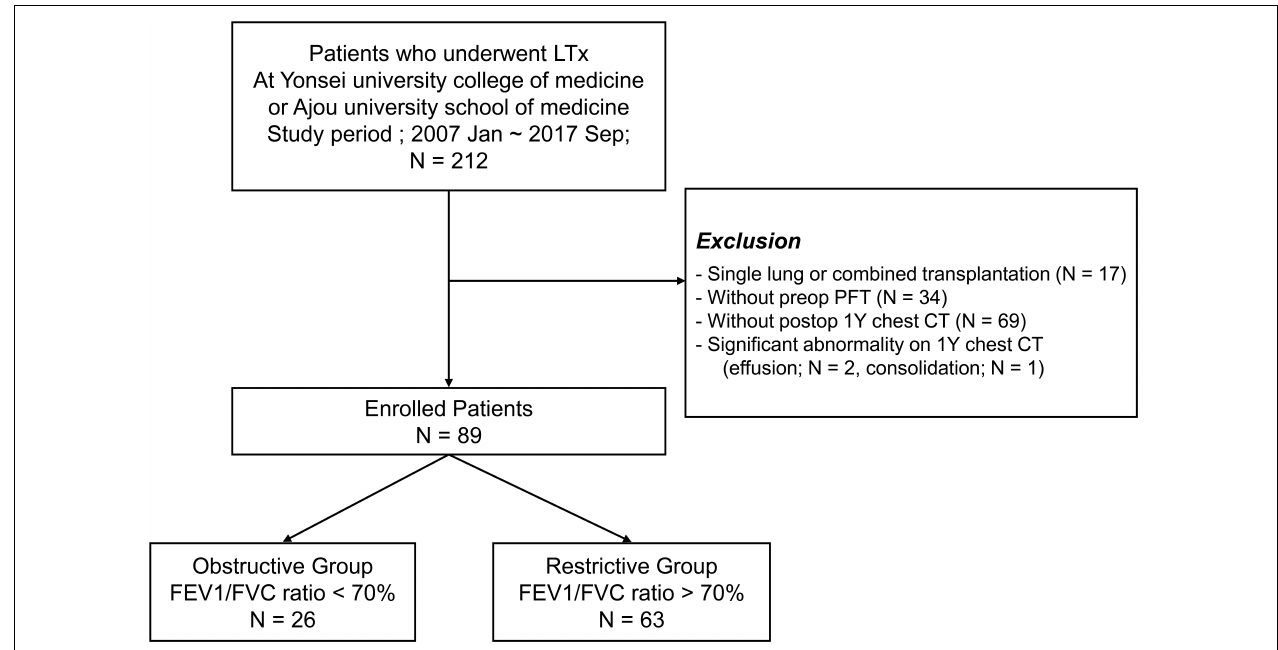
FIGURE 1 | Study population selection. LTx, lung transplantation; preop, pre-operative; postop, postoperative; 1Y, 1